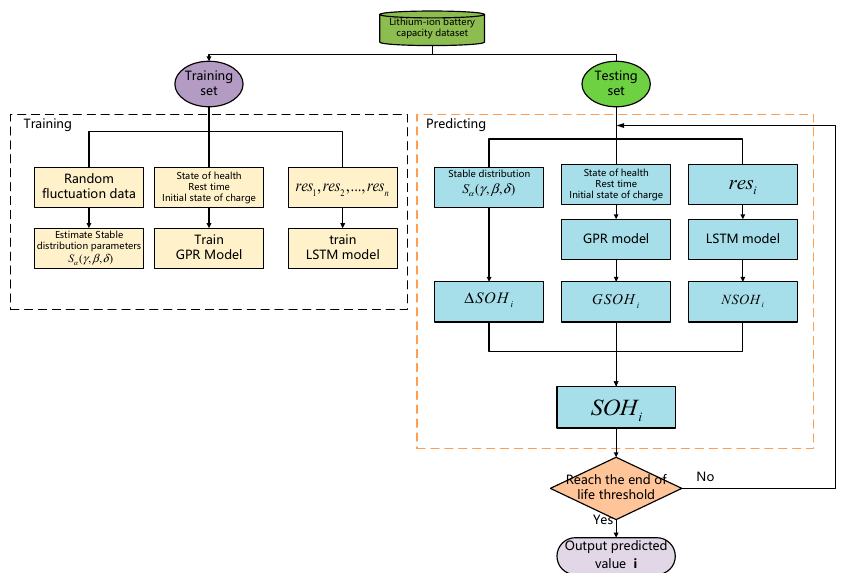
Figure 2. Framework of the proposed algorithm.